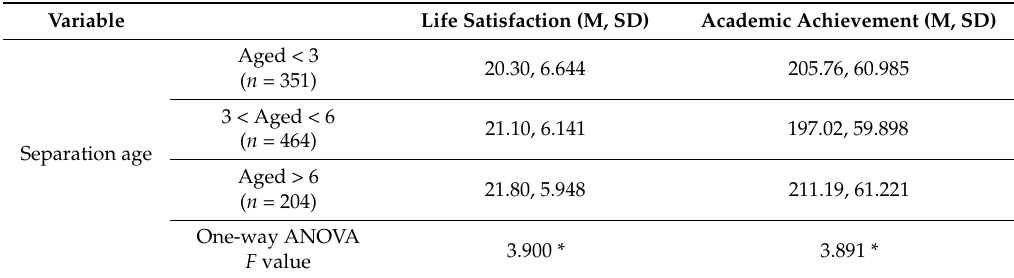
Table 4. Comparison of the life satisfaction and academic achievement of left-behind children (LBC) in rural